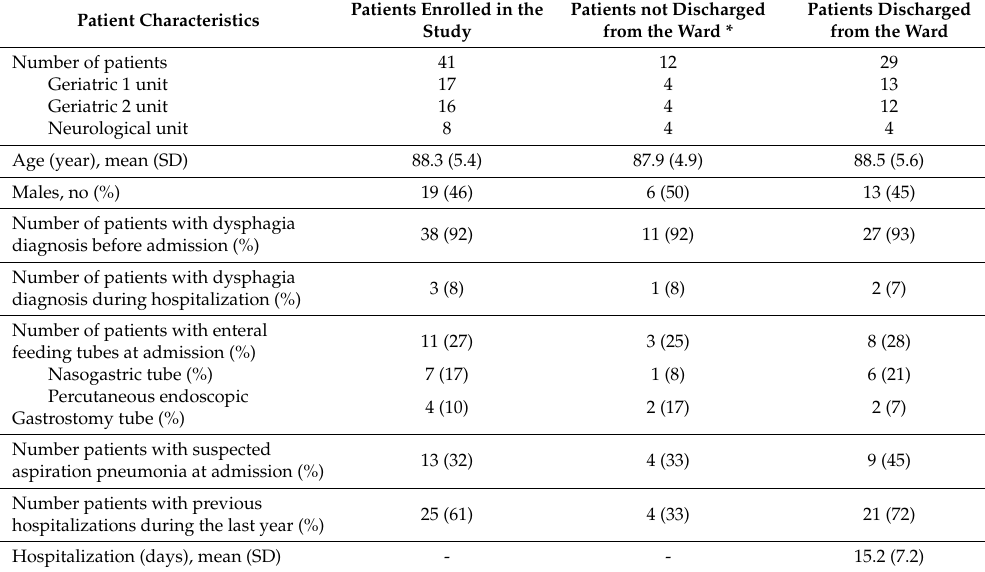
Table 1. General characteristics of the